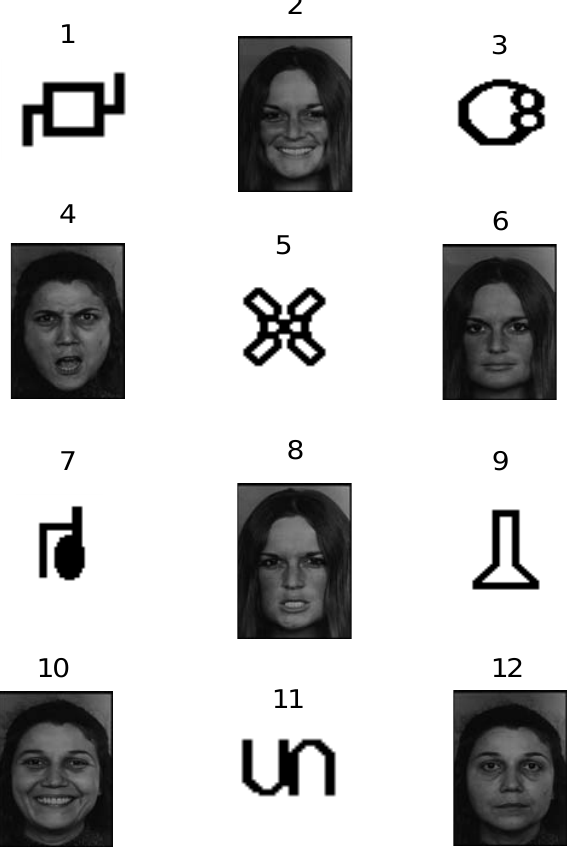
Figura 2 . Estímulos avaliados pelos 196 participantes deste estudo. Os números acima de cada fi gura indicam a ordem de apresentação dos estímulos e não estavam presentes nas folhas entregues aos